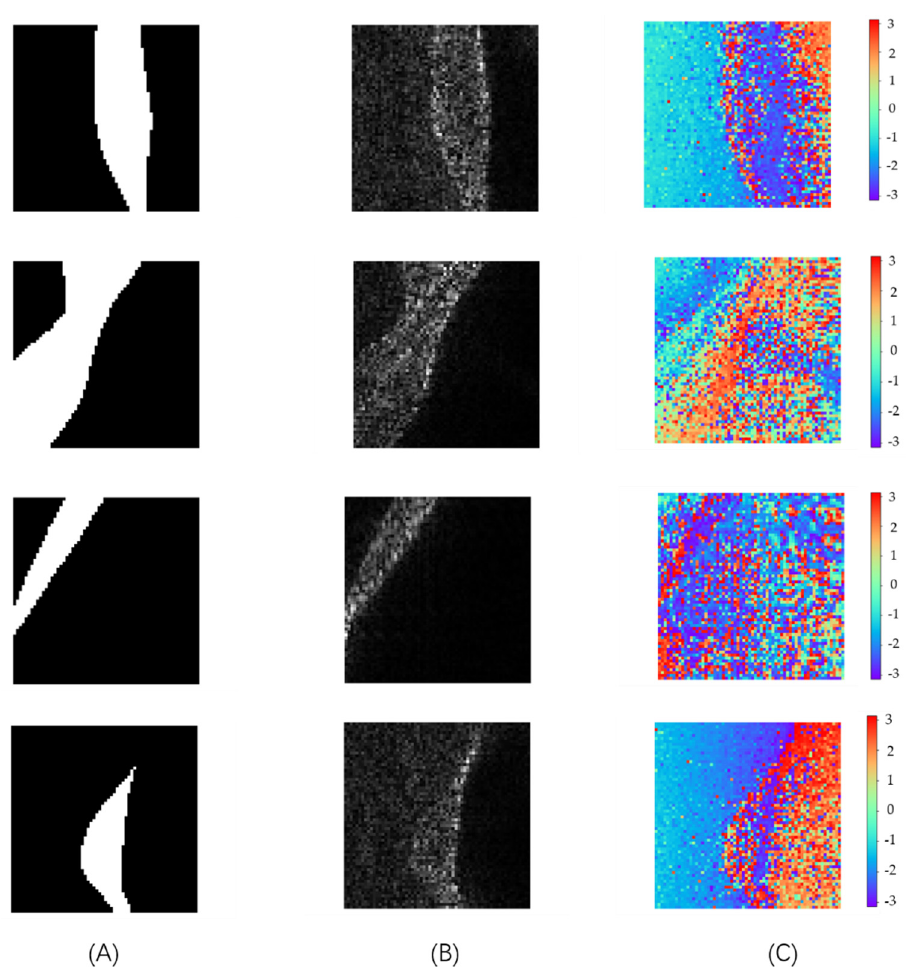
Figure 8. The illustration of the dataset. ( A ) shows the typical truth of pieces in the dataset, ( B ) shows the amplitude information of the corresponding pieces in the dataset, and ( C ) shows the rainbow figure of the interference phase in [ − π , π )